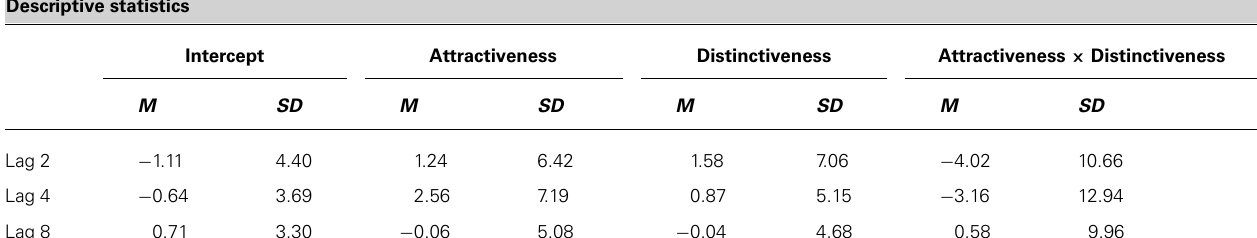
Table 1 | Unstandardized partial coefficients in individual binary logistic regression equations. Descriptive